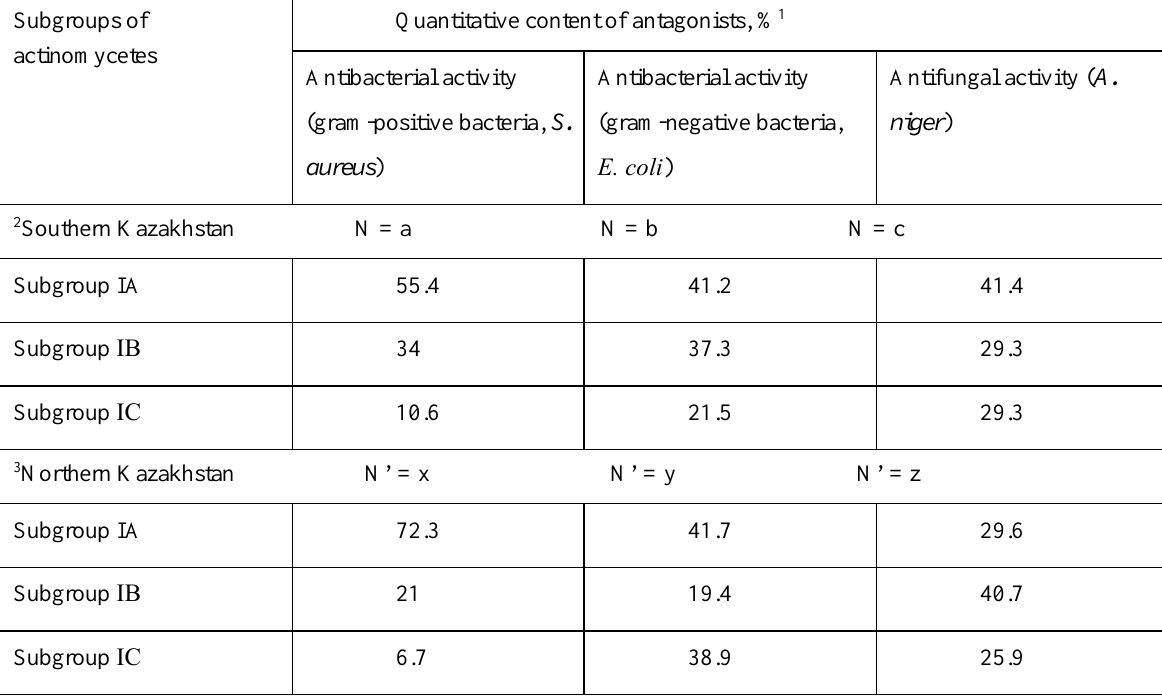
Table 2. The quantitative content of Group I antagonists in the extreme ecosystems of Kazakhstan Subgroups